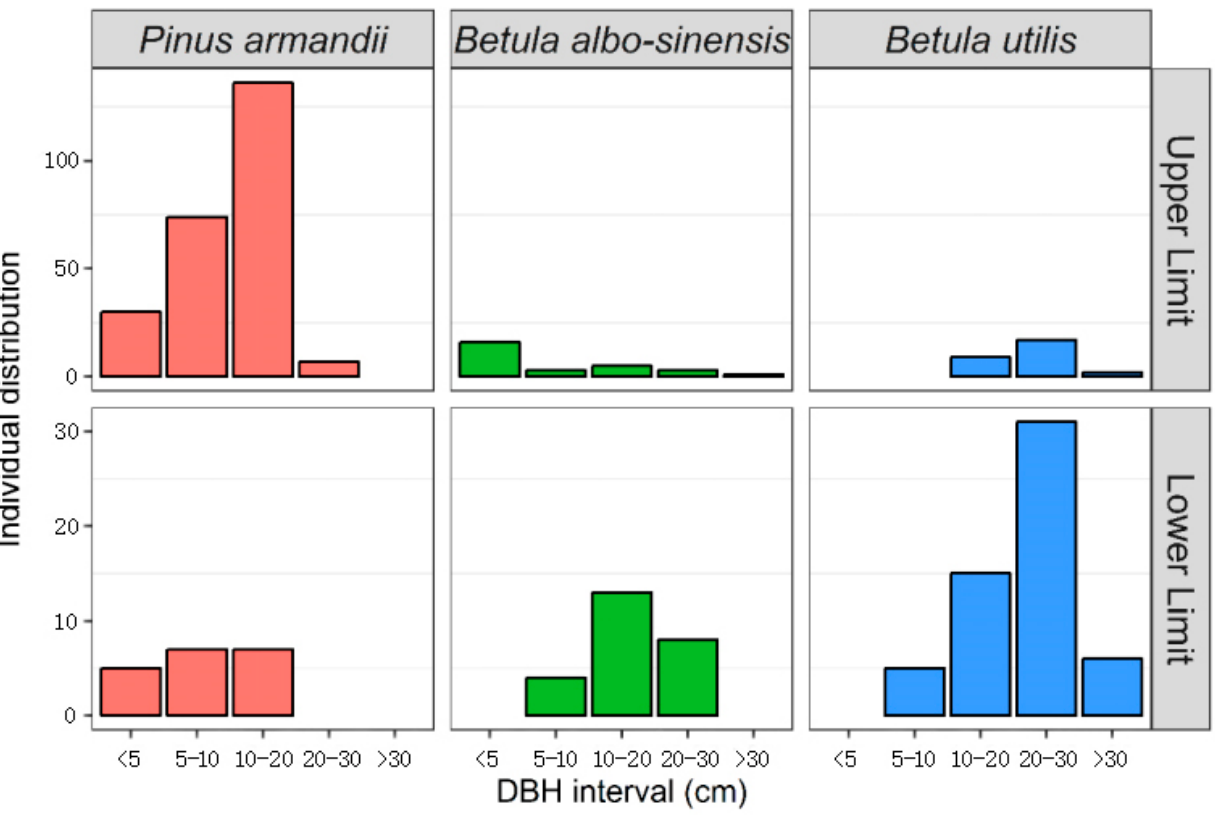
Figure 3. DBH distribution of three species at five diameter intervals (D ≤ 5 cm, 5 cm ≤ D ≤ 10 cm, 10 cm ≤ D ≤ 20 cm, 20 cm ≤ D ≤ 30 cm, D ≥ 30 cm) in the sampling plots of the treeline patch.